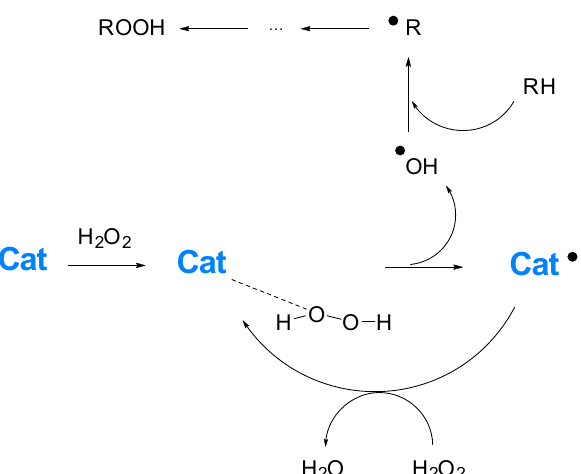
Figure 3. Accumulation of cyclohexanol and cyclohexanone in the oxidation of cyclohexane (0.46 M) with H 2 O 2 (0.5 M containing 0.94 M H 2 O) catalyzed by complex 1 (2.5 × 10 − 4 M) in the presence of HNO 3 (0.05 M) at 40 °C. Concentrations of products were measured by GC after the reduction of the reaction sample with solid PPh 3 . The yield of oxygenates after 60 min was 22% (TON 400). Curves a : the same in the absence of HNO 3 .